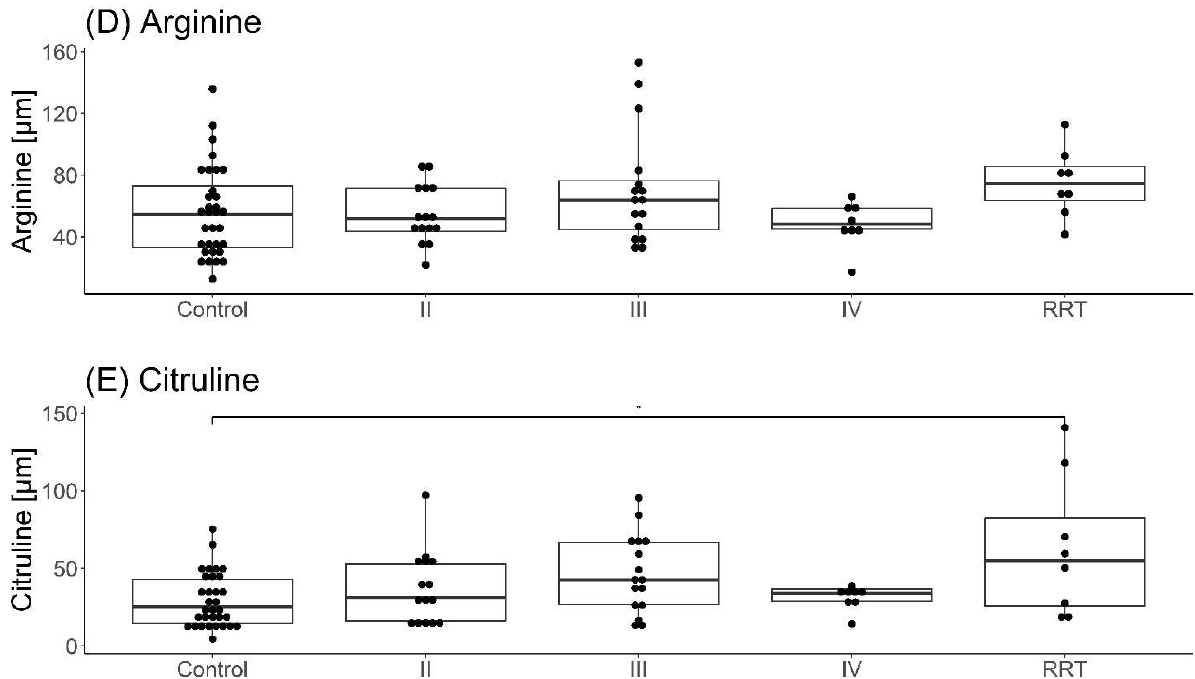
Figure 3. Comparison of differences in parameters depending on the severity of CKD stage (RRT—patients for renal replacement therapy, control—control group, II–IV stages of CKD progression). * p < 0.05, *** p <